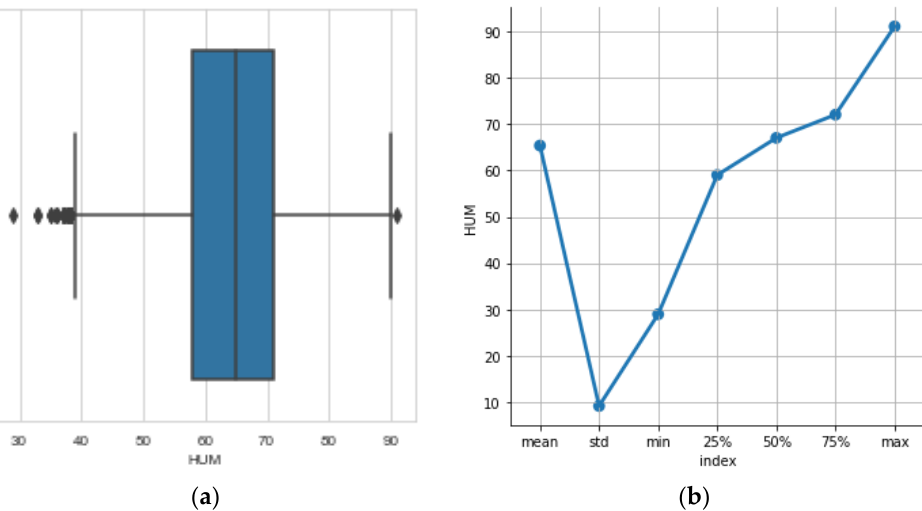
Figure 11. ( a ) boxplots pinpoint outliers in the recordings of humidity. Beehives must not have measurement near 90% RH for a long time as this implies condensation. ( b ) the mean and std values show that the humidity levels are normal inside the hive. Special attention should be given to the 90% RH that is, however, a non-persisting outlier.